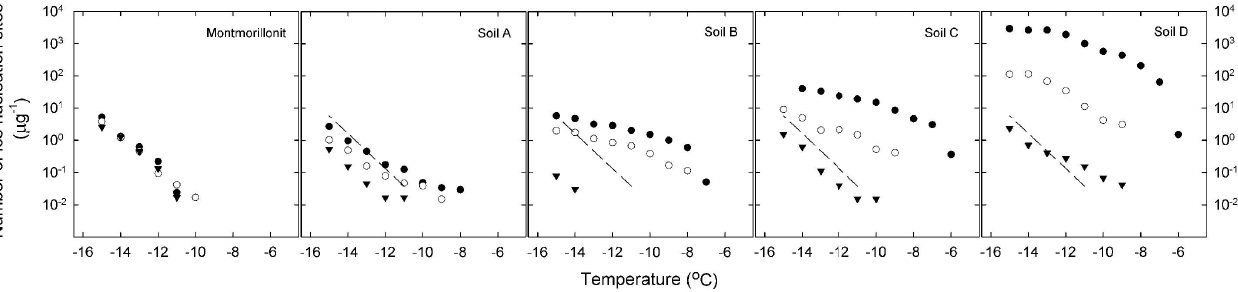
Fig. 1. Freezing properties of montmorillonite and dust particles ( < 15µm) from different soils (A, B, C, D) immersed in distilled H 2 O. Initial numbers of ice nucleation sites ( • ), numbers of ice nucleation sites still active after heating ( ◦ ), and numbers of ice nucleation sites remaining after removal of organic matter ( ∇ ) are shown. Dashed lines indicate the curve for untreated montmorillonite, for comparison.